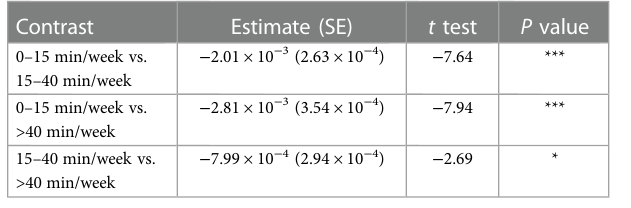
TABLE 4 Pairwise comparisons of slopes by dosage amount group (consistent cohort).